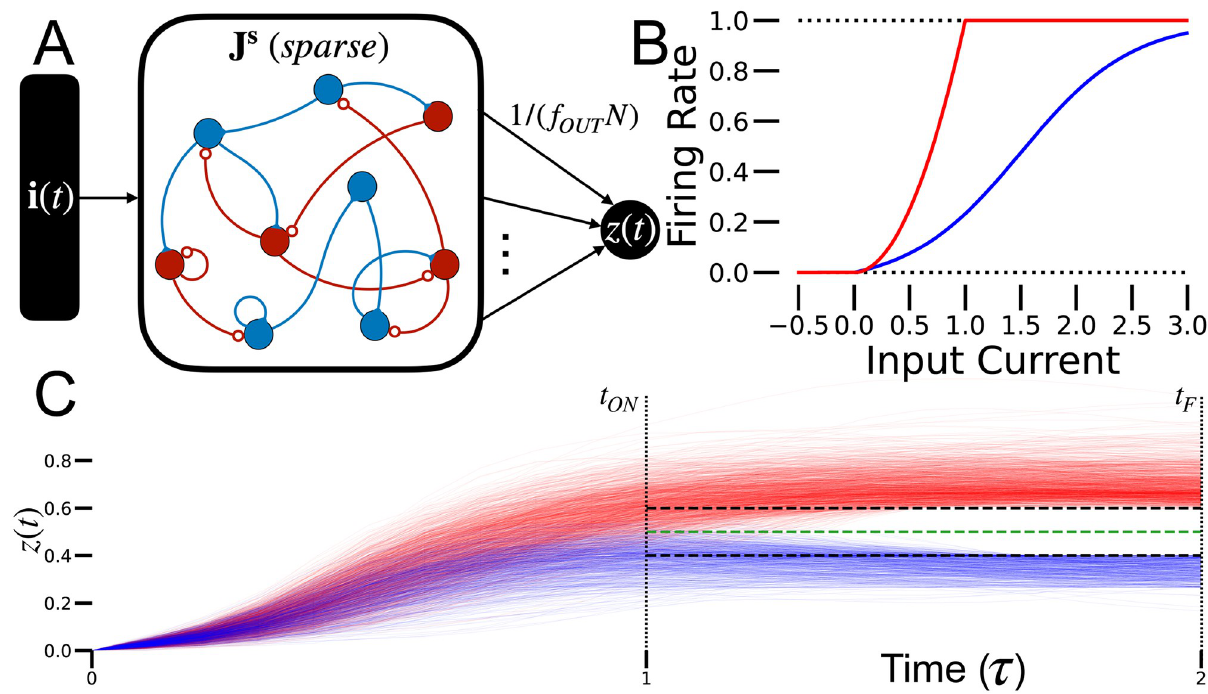
Fig 1. Model description. A: The sparse RNN. Recurrent connections are plastic, but input and output connections are fixed and uniform. We consider both mixed and split excitation-inhibition networks (the split architecture is shown here). B: Examples of activation functions used. Red line is squared rectified linear function, bounded by 1. Blue line is a shifted, scaled and rectified hyperbolic tangent function. C: Illustration of target dynamics training method. Readout activity of trained RNN is shown in red for +1-labeled inputs and in blue for − 1-labeled inputs. The corresponding targets T + and T − are shown as dashed black lines. The threshold θ is the dashed green